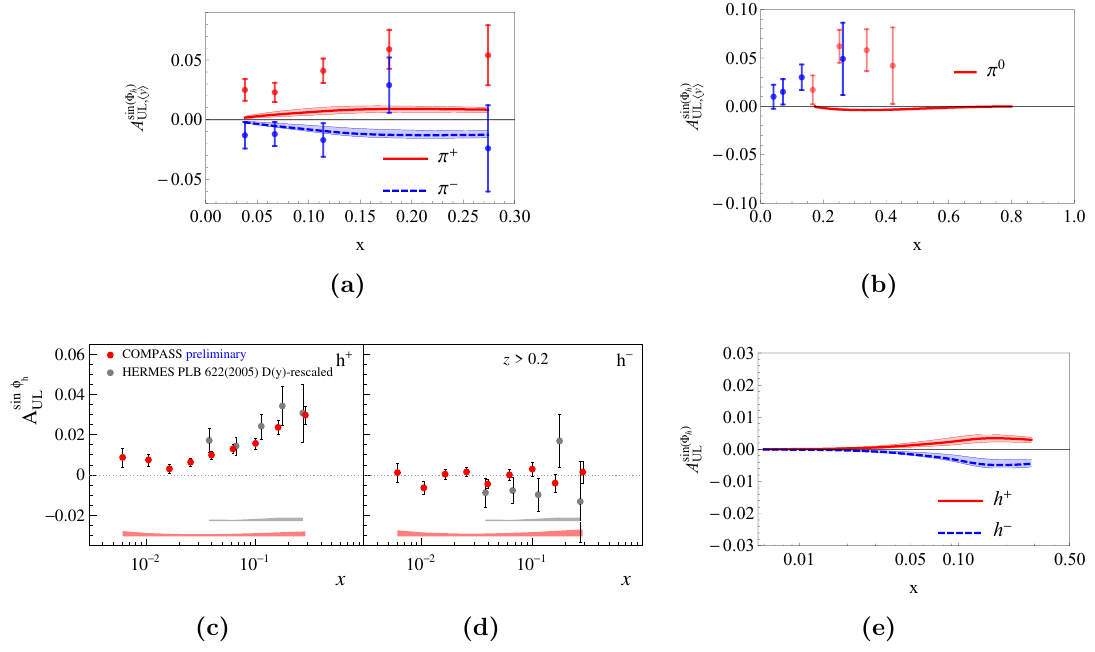
Figure 17. A sin (cid:30) h for proton vs. x from WW-type approximation and comparison to the UL